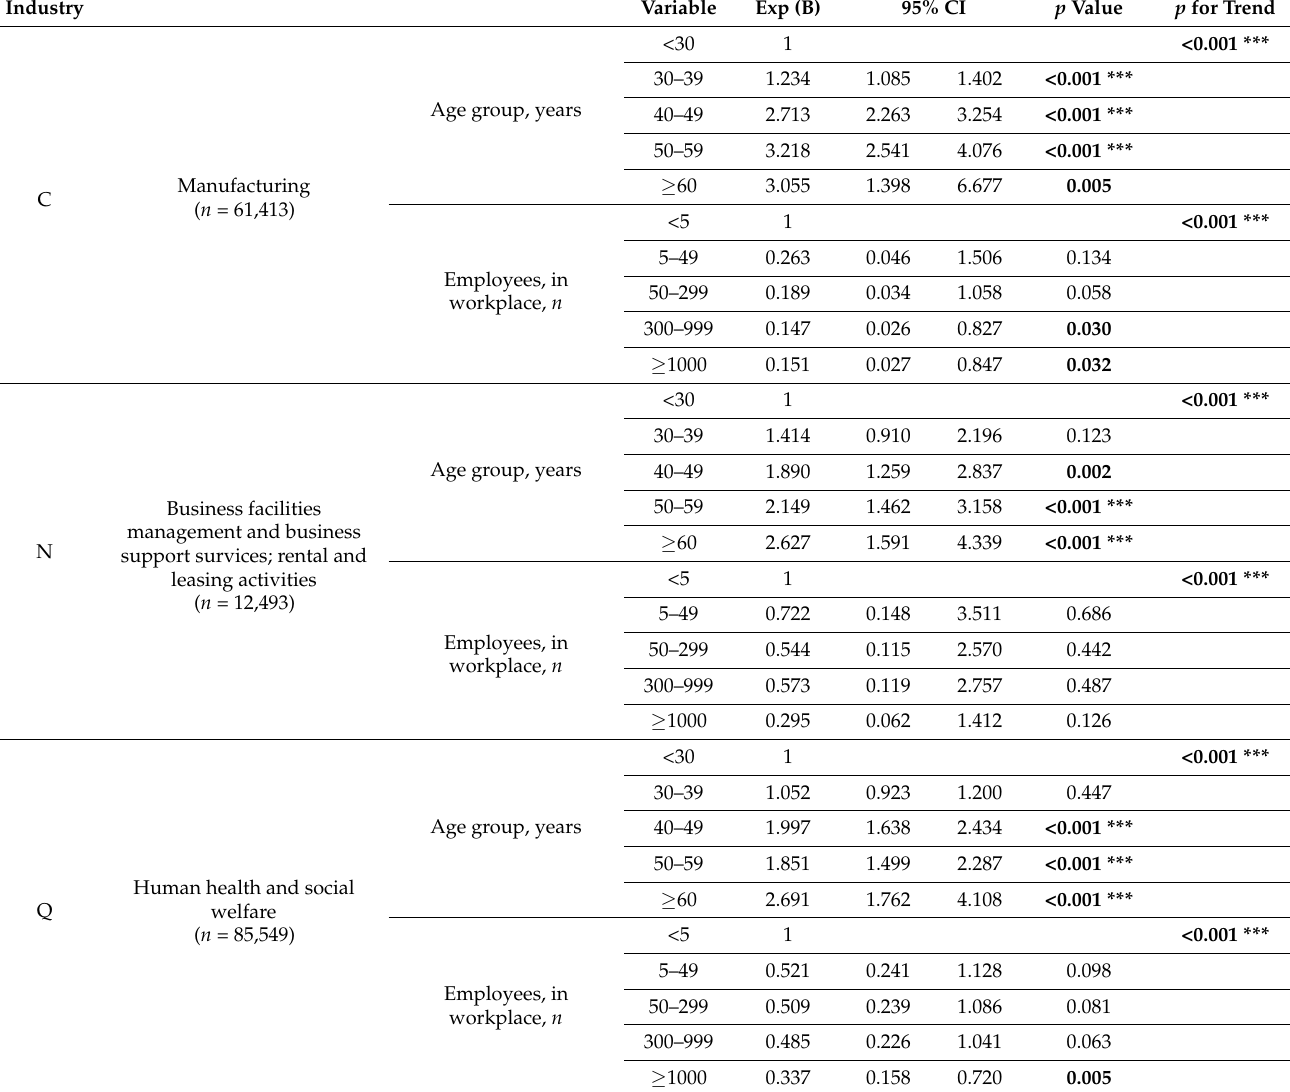
Table 3. Insomnia symptoms of each industry in women from the night-shift Workers’ Specific Health Examination in 2015 *. Industry Variable 95% CI p Value p for